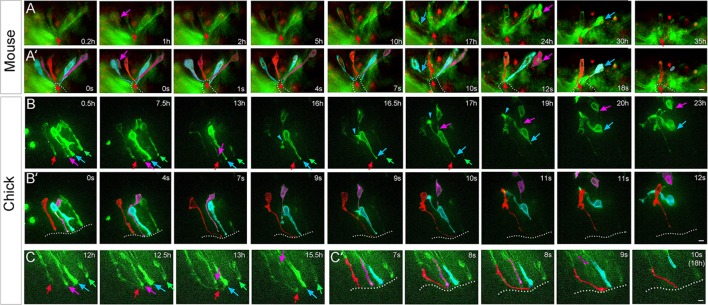
Dorsal collapse involves cell delamination and ratcheting.(A) Sequential stills from time-lapse imaging after electroporation of membrane-GFP histone-RFP into mouse. A midline cell whose morphology indicates it to be a dmNes+RG remains throughout the culture (red arrowhead; in total, 6 such cells observed from 3 slices). dVL cells adjacent to the dmNes+RG delaminate sequentially; on left-hand side, cells delaminate at 1 hour (pink arrow) and 17 hours (blue arrow); on right-hand side, cells delaminate at 24 hours (pink arrow) and 30 hours (blue arrow). (A′) Same images; cells colour-coded. In (A), timeframes refer to real time; in (A′), timeframes refer to S1 Movie. In total, n = 9 stepwise delaminating cells observed from 3 slices. (B) Sequential stills from time-lapse imaging after electroporation of membrane-GFP into chick. Arrows point to endfeet/apical parts of cells. dmNes+RG (red arrow) thins and elongates (0.5–13 hours; elongation observed in 5/6 slices). dVL cells adjacent to dmNes+RG sequentially delaminate (pink and blue arrows 13–16.5 hours; n = 10 cells observed in 5/6 slices). A distant dVL cell remains in situ (green arrow). The middle dVL cell (blue) reaches onto the dmNes+RG/previous dVL cell prior to delamination and dorsal migration (16.5–23 hours; blue arrowheads). (B′) Same images; cells colour-coded. Time frames in (B) refer to real time and in (B′) refer to S3 Movie. (C) A single Z-plane view showing end-feet/apical part of cells shown in (B). dmNes+RG endfoot (red arrow) contacts first dVL cell (pink arrow) at 12.5 hours, which delaminates at 13 hours. dmNes+RG endfoot contacts the second dVL cell (blue arrow) at 13 hours, which delaminates around 15.5 hours. (C′) Same images; cells colour-coded. Timeframes in (C) refer to real time and in (C′) refer to S4 Movie. dmNes+RG, dorsal midline Nestin(+) radial glia; dVL, dorsal ventricular layer; GFP, green fluorescent protein; RFP, red fluorescent protein.